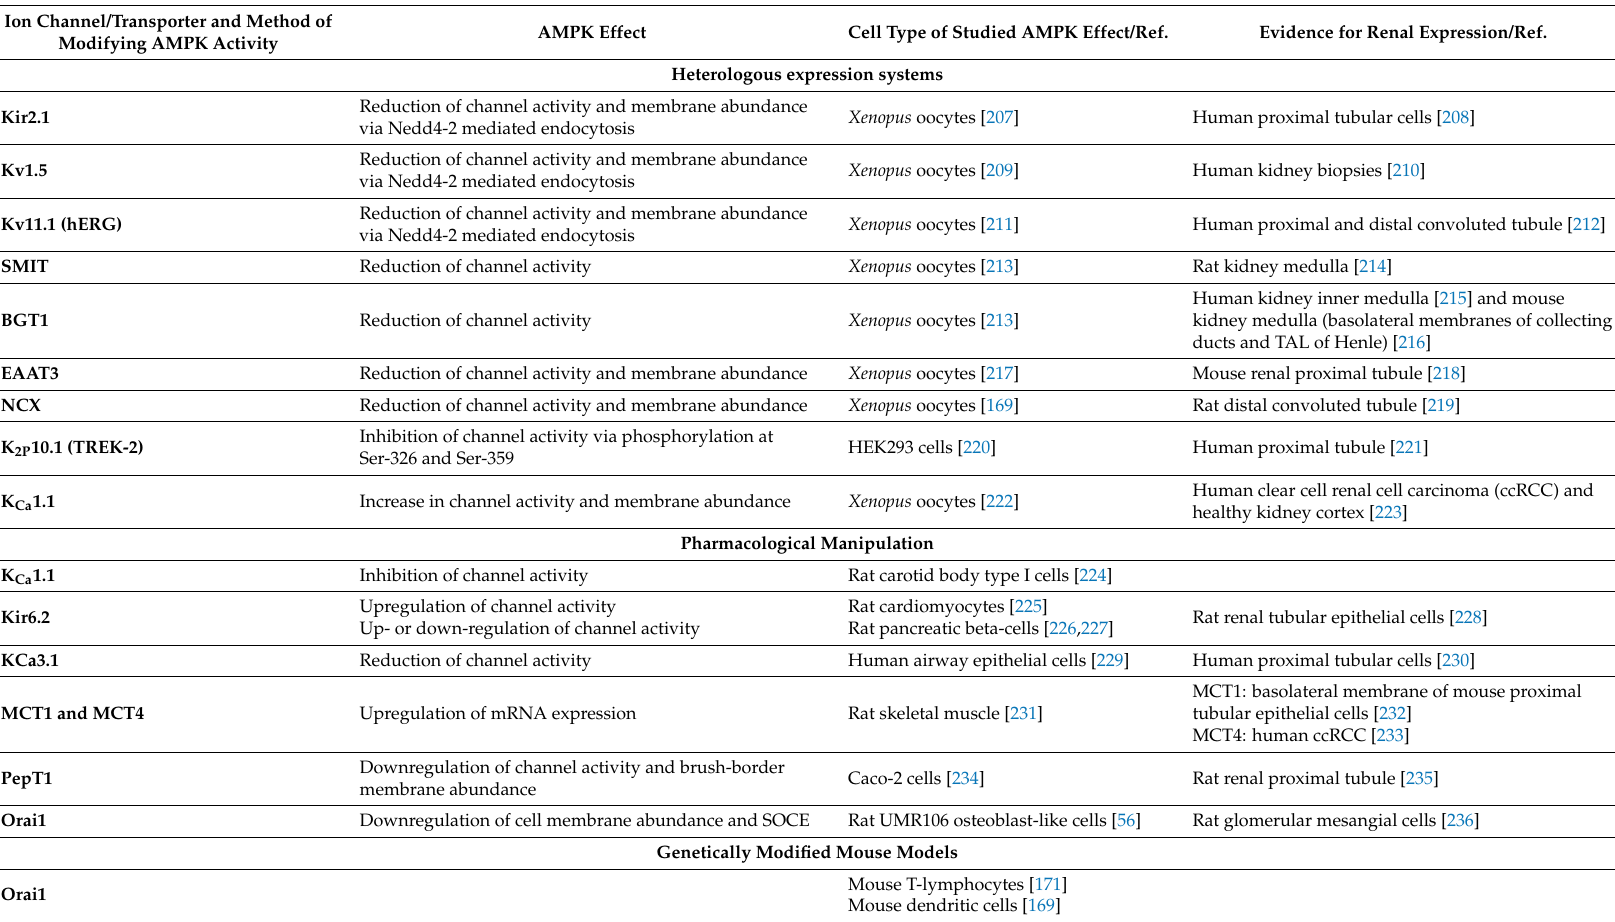
Table 1. Overview of transport proteins regulated by AMPK in extrarenal tissues and evidence for renal